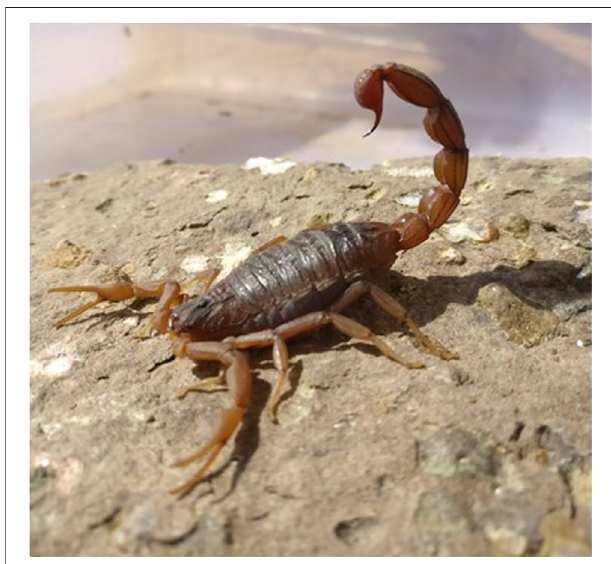
FIGURE 1 | Indian red scorpion (Mesobuthus tamulus) (Photo courtesy, Dr. M. V.